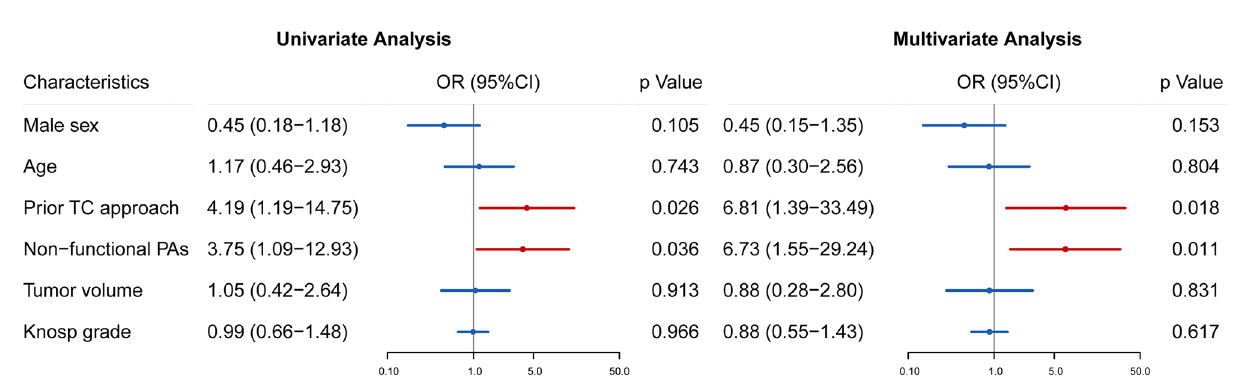
TABLE 3 | Preoperative Characteristics of non-rrPAs and rrPAs after propensity score matching.